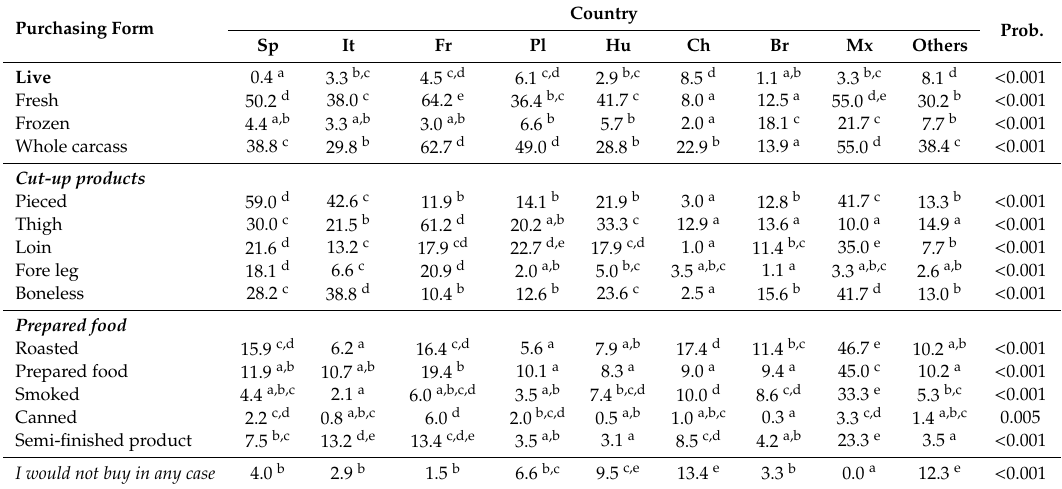
Table 7. E ff ect of purchase forms on the respondents’ attitude depending on the countries with multiple response